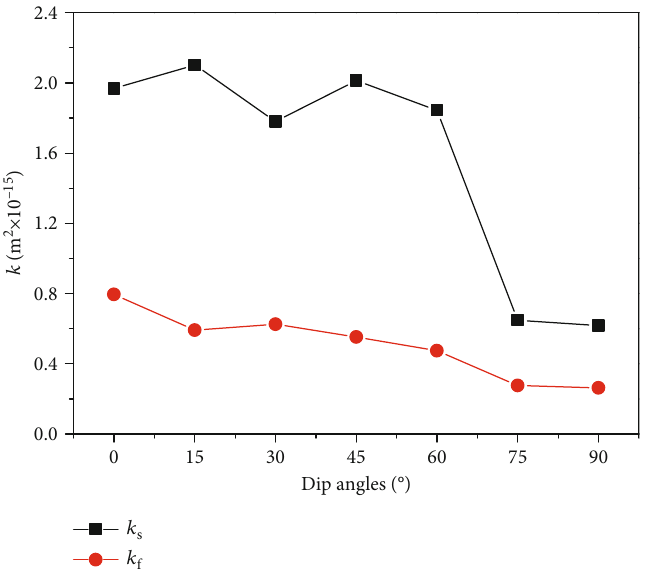
k Figure 12: k s and f of samples with di